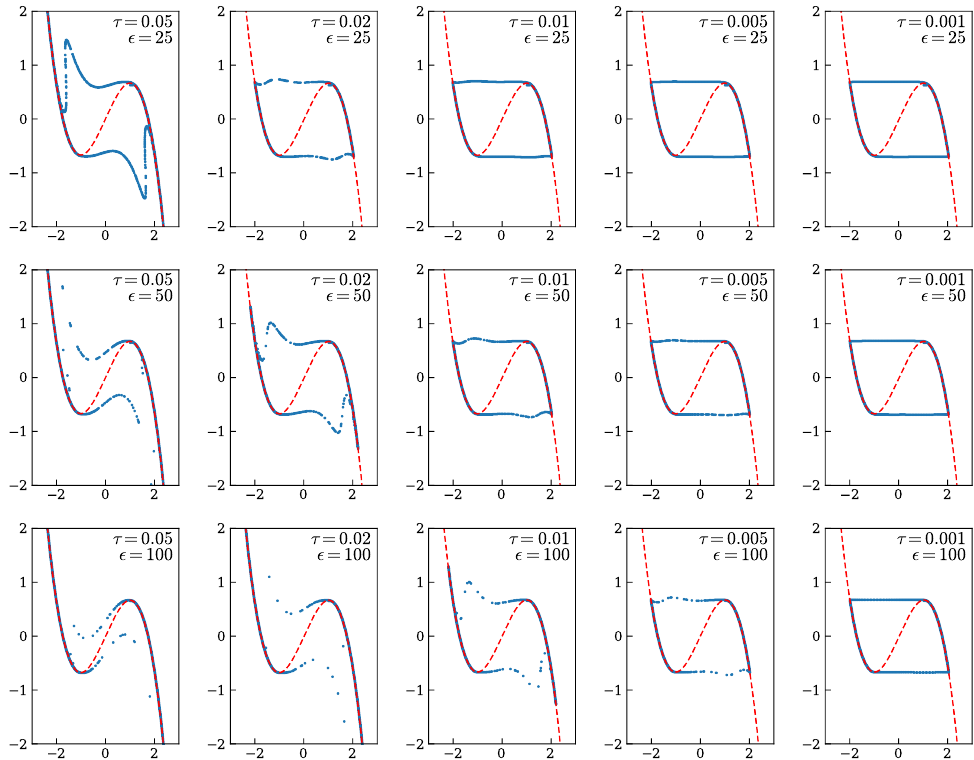
Figure 6. Orbits for the stiff van der Pol oscillator obtained with the second-order contact integra- tor for different values of the coupling (cid:101) and of the time step τ after the Liénard transformation: With (cid:101) ∈ { 25,50,100 } increasing from top to bottom and τ ∈ { 10 − 2 ,5 × 10 − 3 ,10 − 3 ,5 × 10 − 4 ,10 − 4 } decreasing from left to